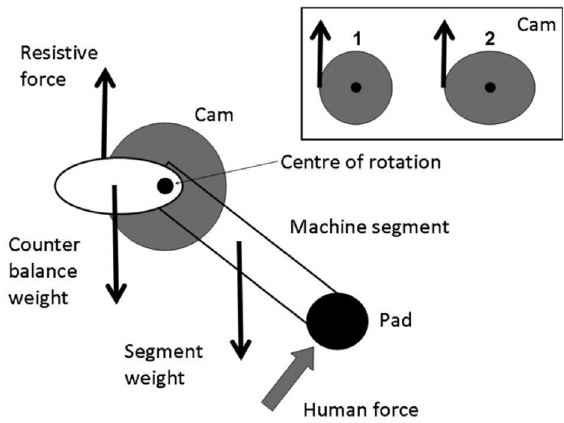
Figure 1 - Illustration of the mechanical components of the knee extension machine used as default in musculoskeletal modelling. Resistive force vector indicates the line of action of the cable of the resistive weight on the machine. Highlight of the possible change in radius of the cam. Knee extension performed concentrically